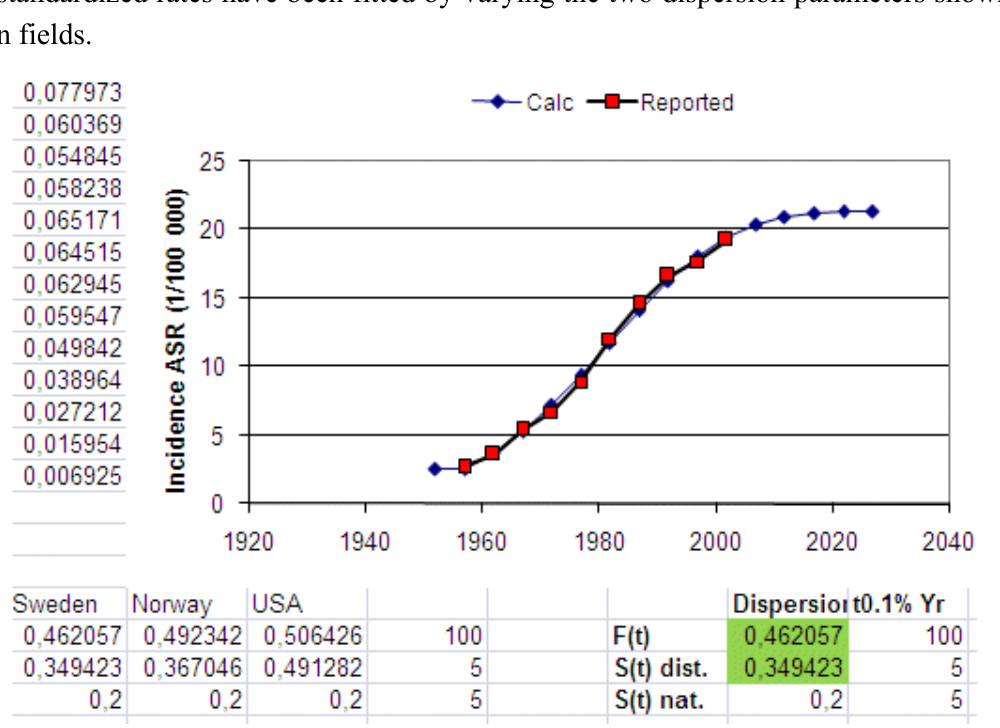
Figure 20. ( a ) Reported age-specific incidence, for men in Sweden [2]. ( b ) Calculated age-specific incidence for men in Sweden